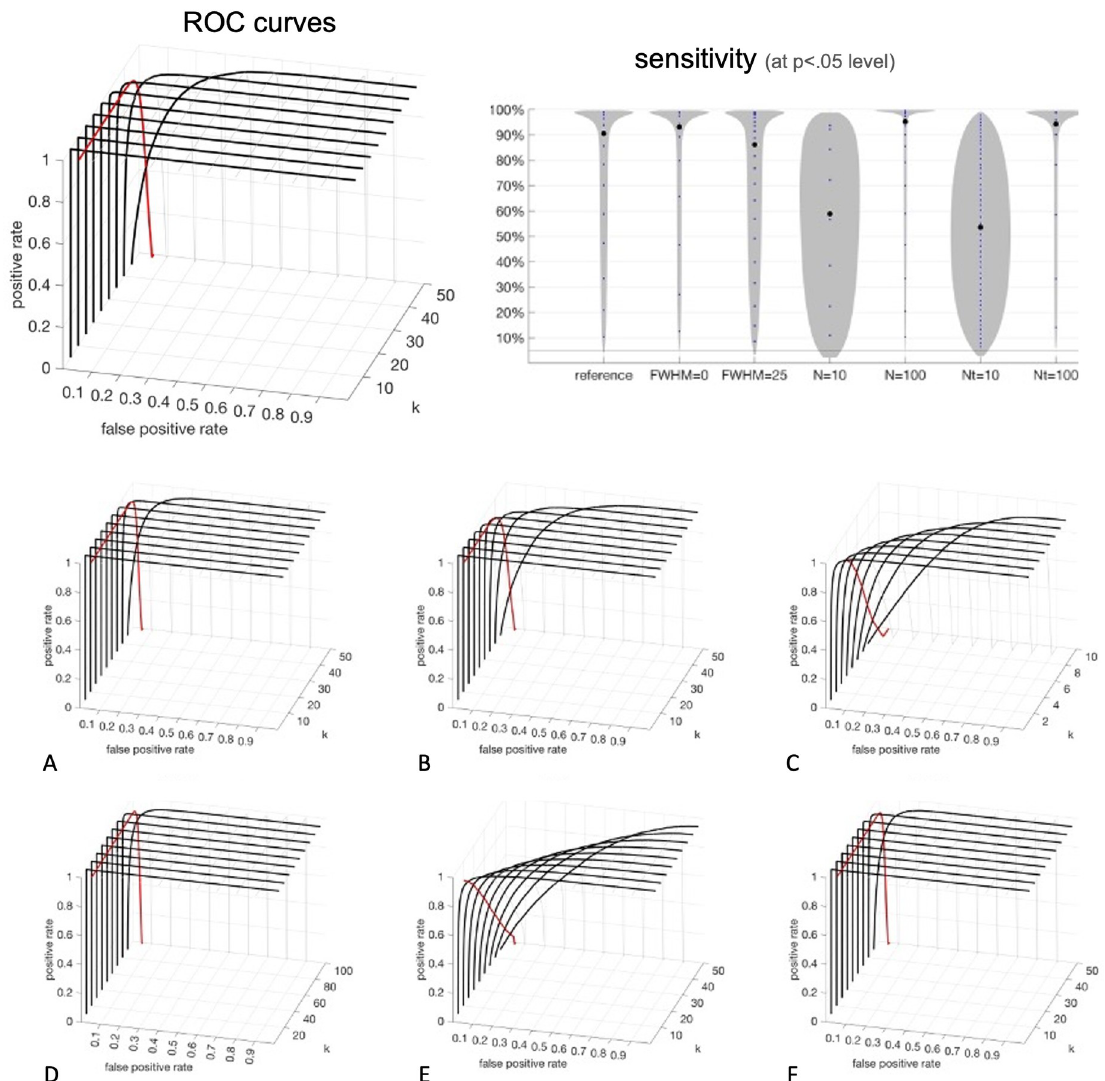
Fig 8. Sensitivity of fc-MVPA voxel-level inferences. Analysis of Receiver Operating Characteristic curves evaluating between-group differences in functional connectivity. Top Left : surfaces, and highlighted thick black lines, show, for a chosen combination of false positive threshold ( false positive rate x-axis) and number of eigenpatterns ( k y-axis), the resulting proportion of true positive results ( positive rate z- axis), where the fc-MVPA procedure would correctly conclude there is a significant difference in connectivity between the groups in our reference simulations. Top Righ t: Observed true positive rates (y-axis) when using fc-MVPA statistical analyses controlled at a p < .05 level across the reference simulations (‘reference’) and simulations evaluating different conditions (FWHM = 0, FHWM = 25, N = 10, N = 100, Nt = 10, Nt = 100). The average (black dots) and histogram (gray surfaces) of the observed true positive rates, or proportion of significant results, across these simulations indicate that sensitivity is typically higher when using low or intermediate numbers of eigenpatterns, with poorer sensitivity when the number of timepoints for functional connectivity estimation is low (Nt = 10), or when the number of subjects included in the analysis is low (N = 10). Bottom : evaluating sensitivity under different conditions: ( A ) no spatial autocorrelation (FWHM = 0); ( B ) large spatial autocorrelation (FWHM = 25 voxels); ( C ) low number of subjects (N = 10); ( D ) high number of subjects (N = 100); ( E ) short scanning session (Nt = 10); ( F ) long scanning session (Nt = 100).